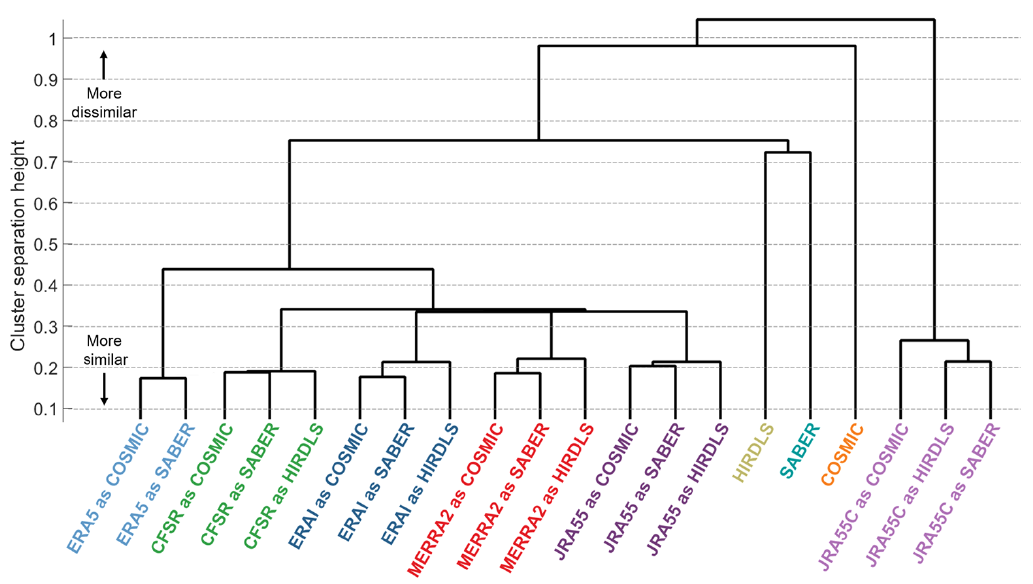
Figure 17. Dendrogram illustrating results of cluster analysis on co-located measurement pairs. This shows each dataset as a leaf on a hierarchical tree. The vertical distance up the page at which two branches split indicates the relative dissimilarity of the datasets joined by the branches. Horizontal distance does not imply any information, and the leaves are distributed horizontally to produce a simple tree. All co-located measurements have been compared at 30km in